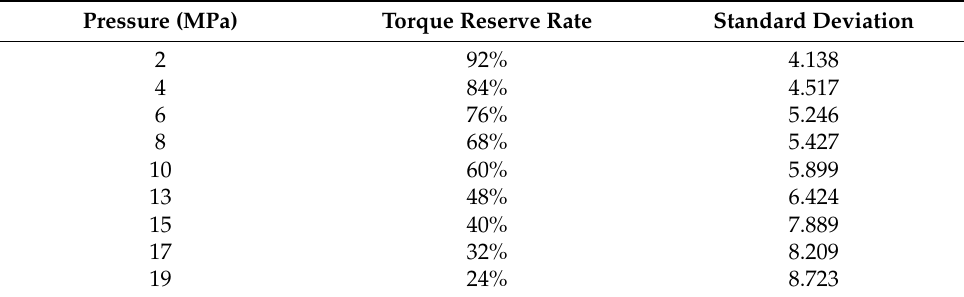
Table 3. Rotation speed–pressure–standard deviation table.